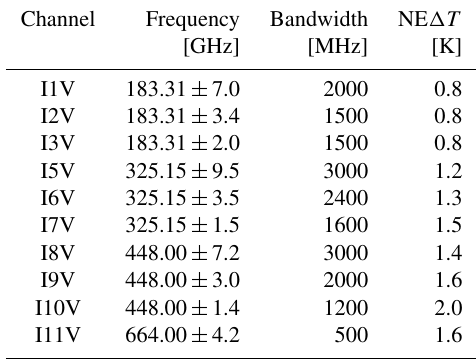
Table 2. Specifications of ICI channels relevant to this study. Channel